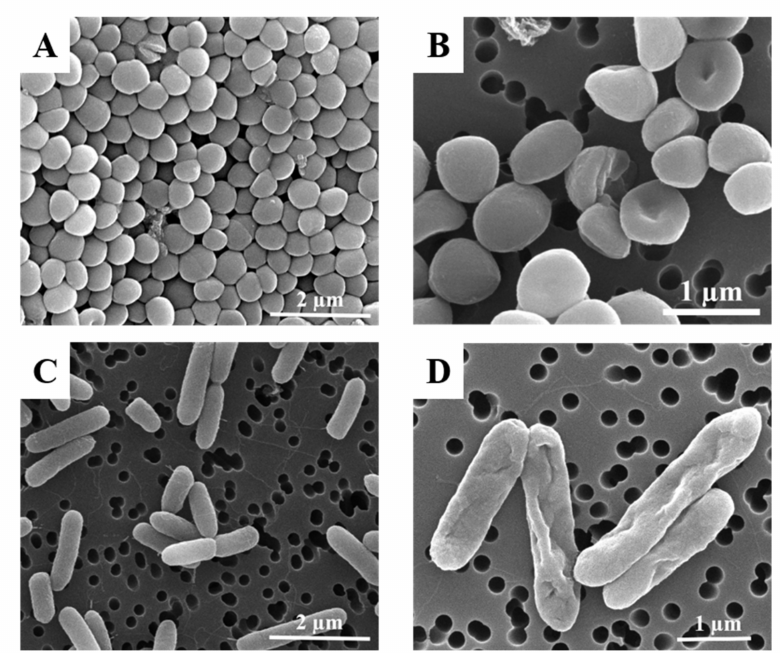
Figure 7. SEM images S. aureus ( A ) control; ( B ) after 24 h of treatment with AZT MPs; P. aeruginosa ( C ) control; ( D ) after 24 h treatment with AZT MPs at MIC concentrations.